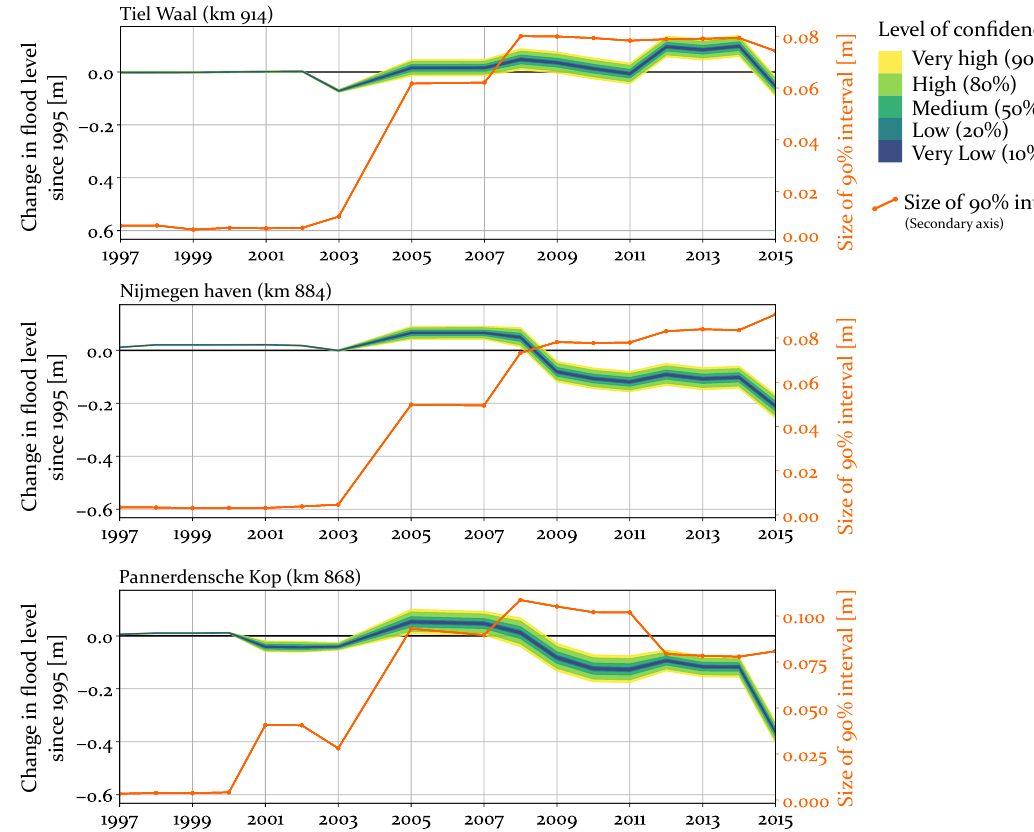
Figure 5. Confidence intervals for the simulated change in flood levels since 1995 (projected on the primary (left) axis) and the size of the 90% interval, projected onto the secondary (right)